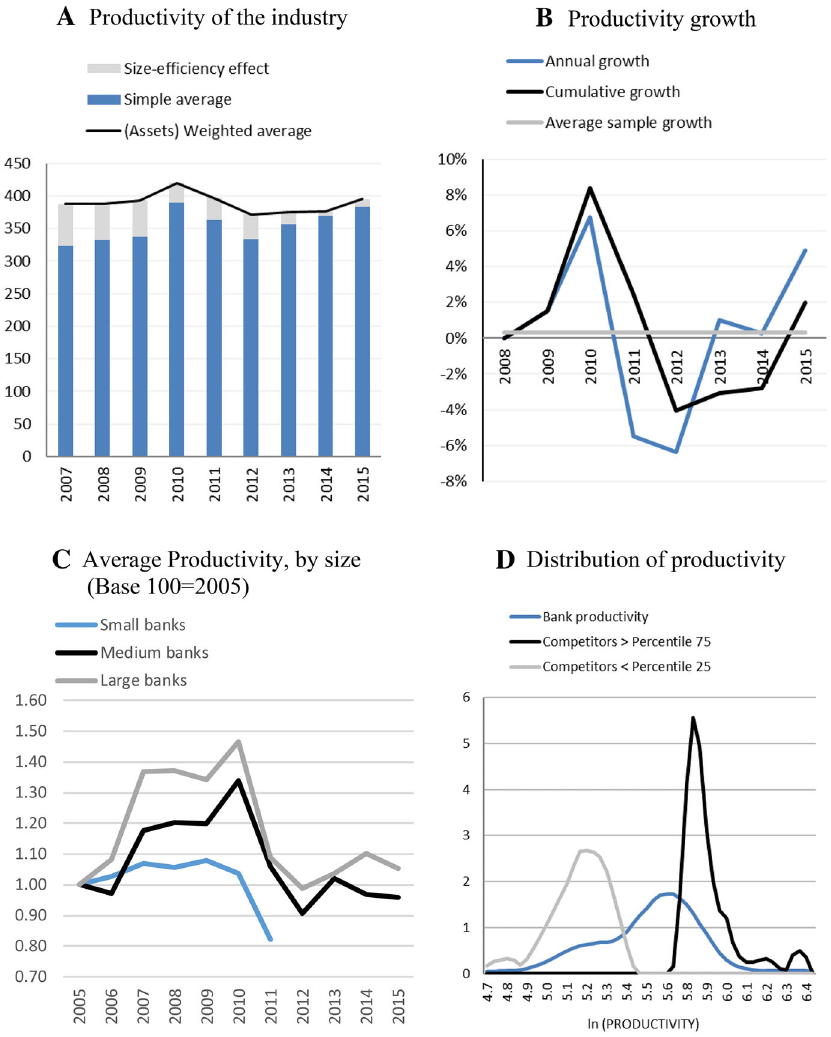
Fig. 2 Productivity of the banking sector. a Productivity of the industry. b Productivity growth. c Average productivity, by size. d Distribution of productivity (base 100 (cid:2) 2005)